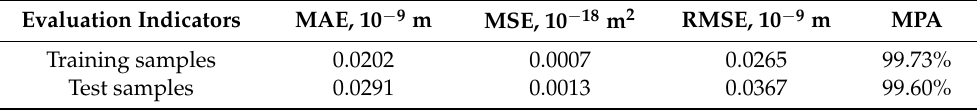
Figure 10. The comparison of the results of the GMDRMS training set.